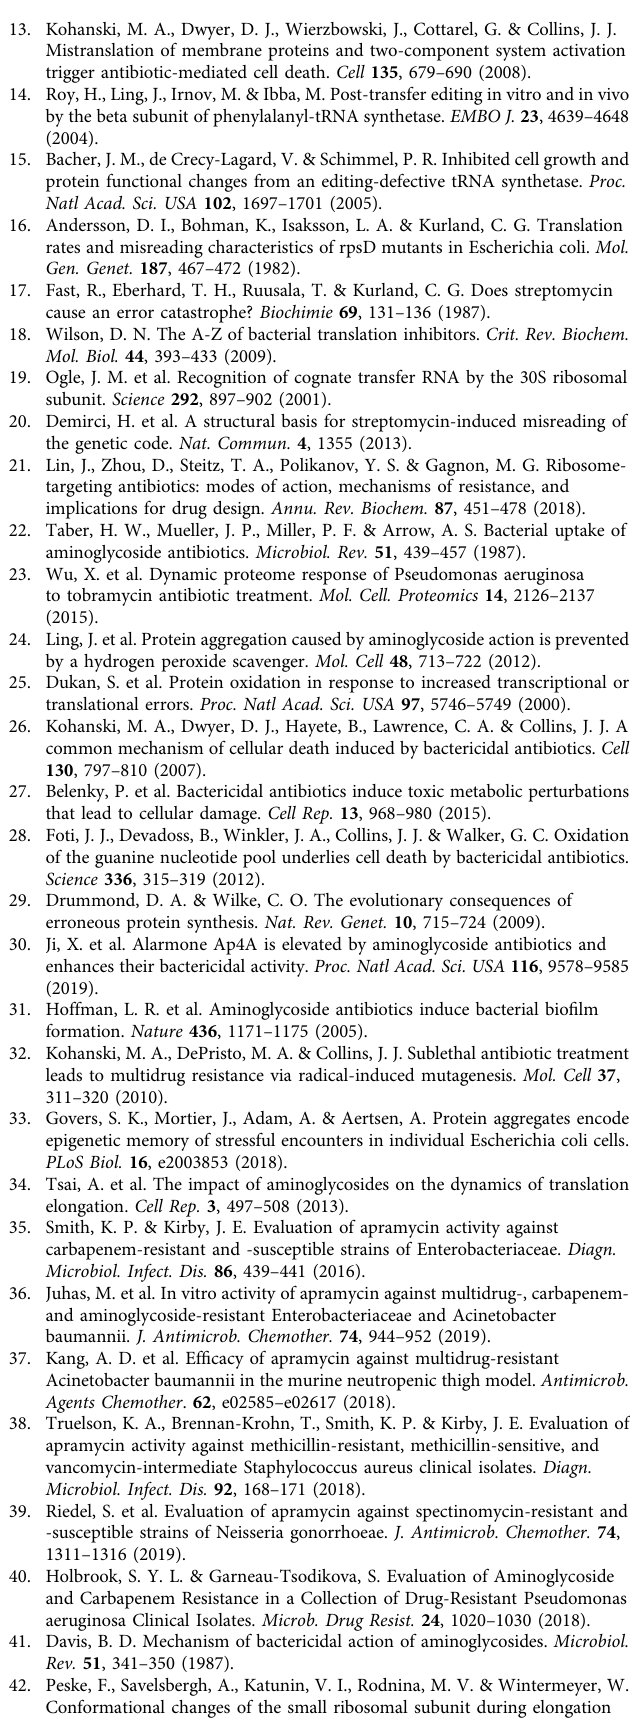
Supplementary Fig. 3a – c): For the analysis of error ampli fi cation correct peptides, peptides with error clusters and with the fi rst and the second error alone have to